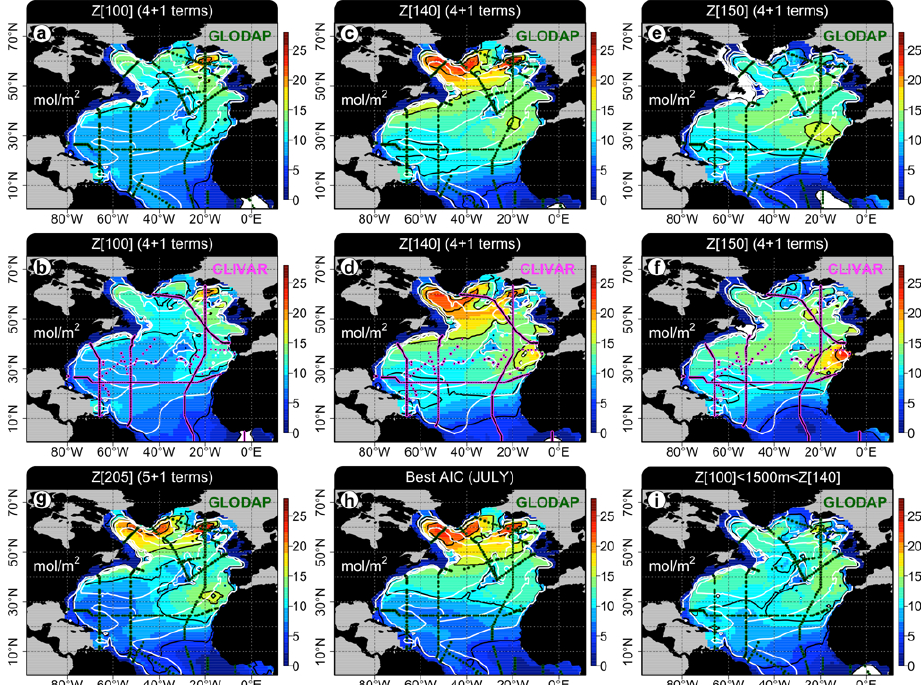
Fig. 10. Calculated eMLR anthropogenic carbon column inventory change between July 2005 and 1995 mapped from either the GLODAP (green) or CLIVAR (magenta) stations when the sampling networks change in time ( 1C hybrid ). Black contours are drawn in increment of X 5molm − 2 . White contours reproduce the shape of the best possible pattern obtained from mapping the true values sampled at the station loca- tions (1b). Results are shown for models (a, b) Z 100 = { S,θ, PO 4 , O 2 } , (c, d) Z 140 = { θ, PO 4 , Si , Alk } , (e, f) Z 150 = { NO 3 ,PO 4 ,Si,Alk } , (g) Z 205 = { θ, NO 3 , Si , AOU , Alk } , (h) for the “best AIC” models selected by minimum AIC for each layer and each time point (strategy 1) and (i) the merged product using Z 140 below 1500m and Z 100